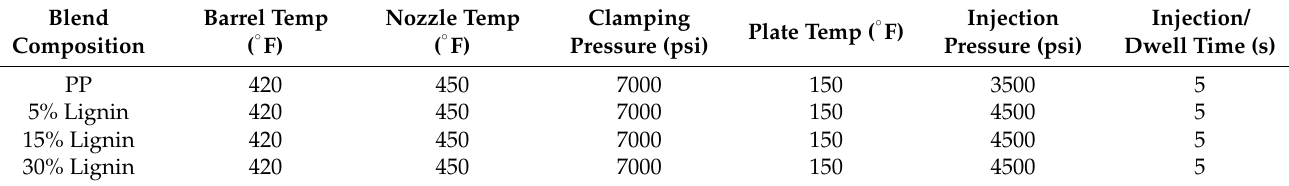
Table 1. Injection molding